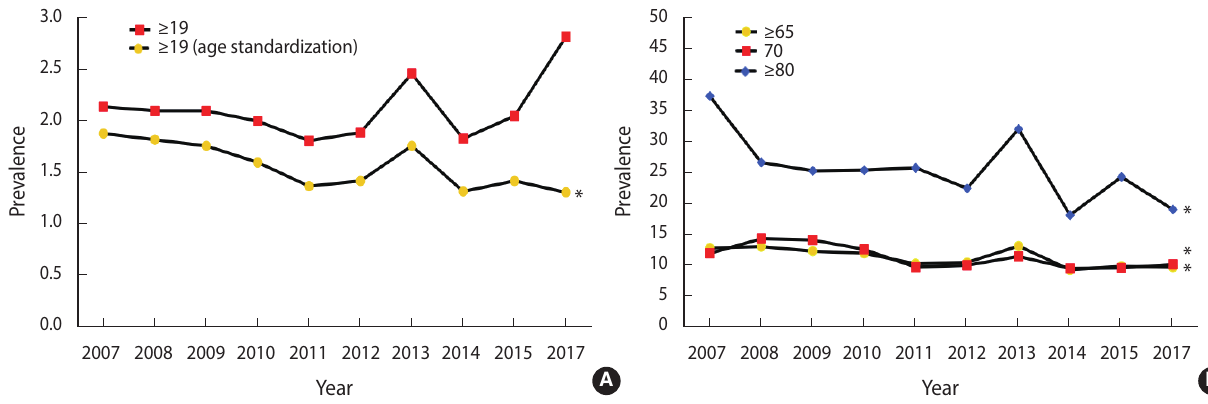
Figure 1. Trend analysis of edentulism in Korea National Health and Nutrition Examination Survey by age (A: ≥19 yr, B: ≥65 yr). *p<0.05 for trend